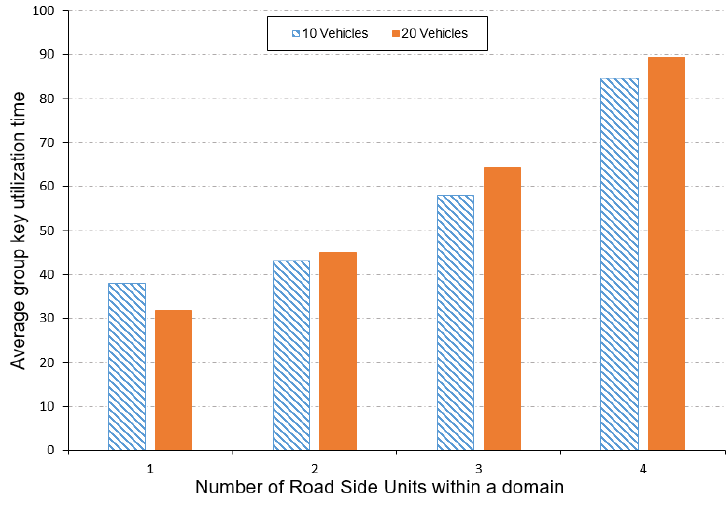
Figure 6. Group key